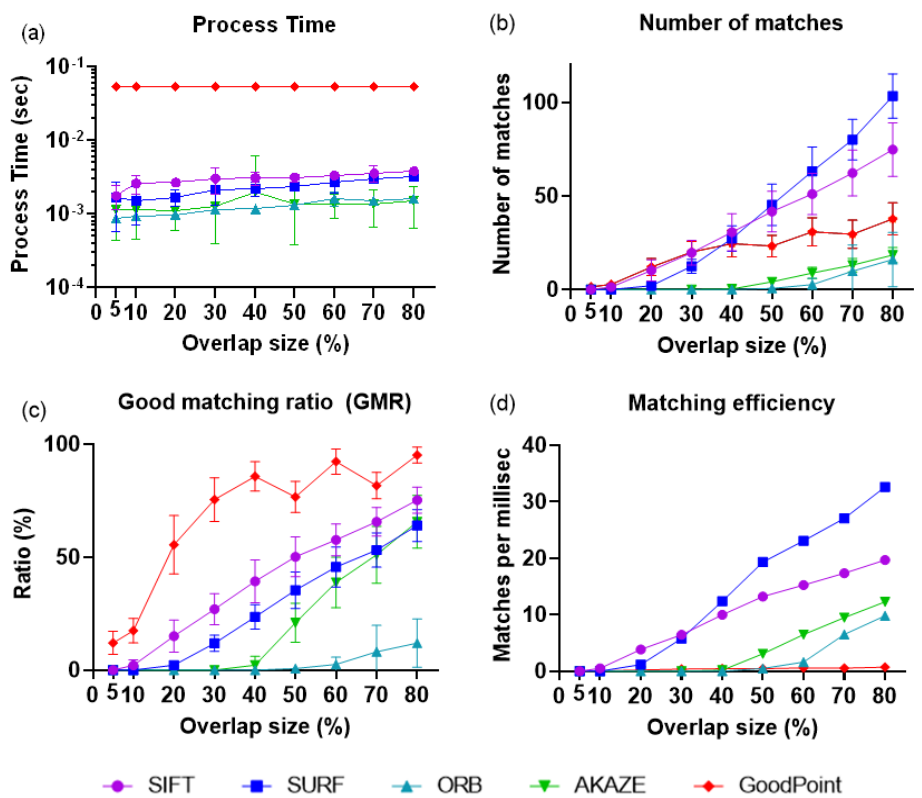
Figure 6. Performance comparison among different feature based matching methods. ( a ) Processing time, ( b ) number of matches, ( c ) good matching ratio, ( d ) matching efficiency.